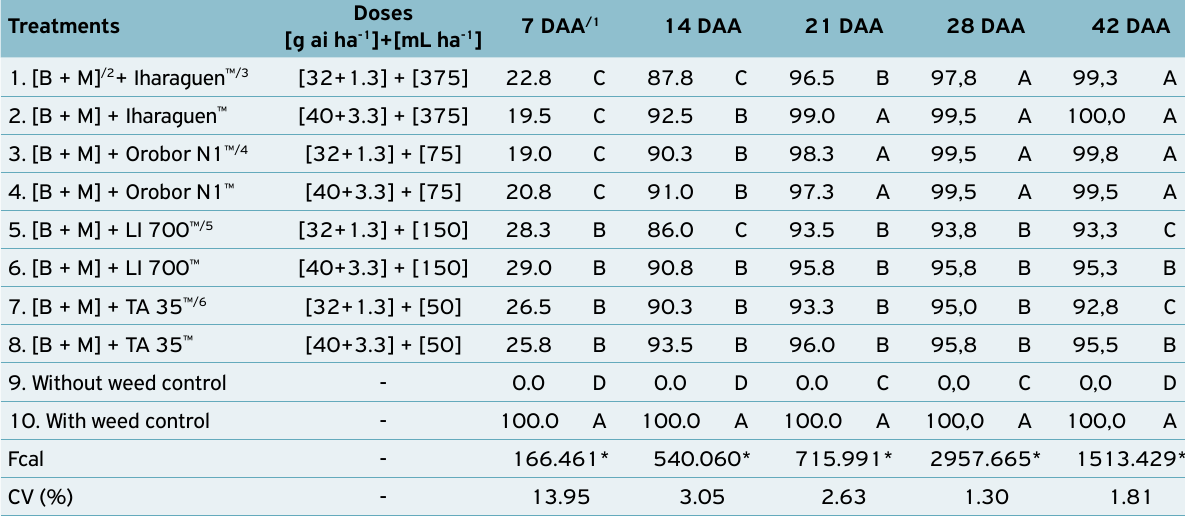
Table 2. Control percentage of globe fringerush ( Fimbristylis miliacea ) using the in-tank mixture of bispyribac-sodium + metsulfuron- methyl [B + M] applied in post-emergence of irrigated rice crop, at different doses and adjuvants.